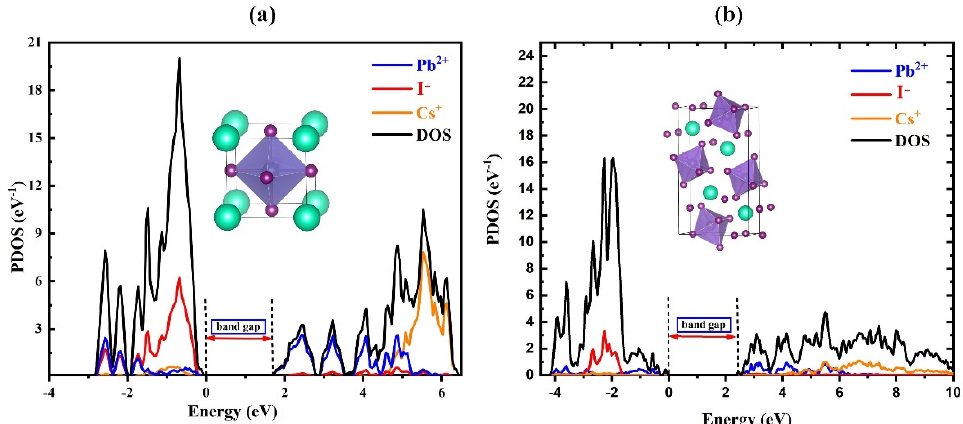
Figure 3. Calculated DOS of the pure inorganic perovskite in VBM and CBM: ( a ) CsPbI 3 − Cubic, ( b ) CsPbI 3 − Orthorhombic.